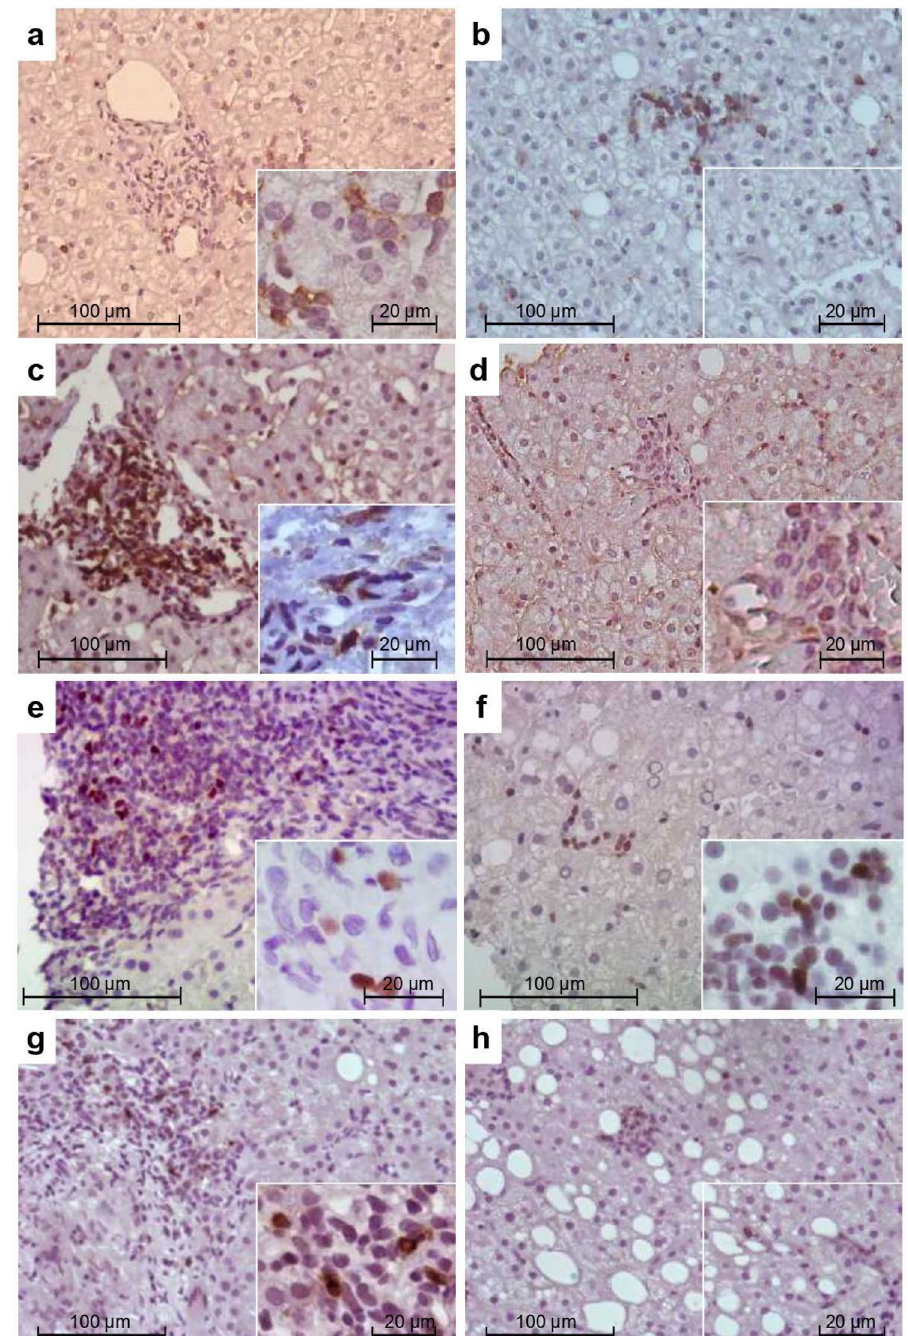
Figure 1. Immunostaining of liver infiltrating lymphocyte populations on formalin-fixed liver biopsies. CD8+ ( a , b ), CD4+ ( c , d ), Foxp3+ ( e , f ) and IL-17A+ ( g , h ) cells. Representative images of portal-periportal ( a , c , e , g ) and intralobular ( b , d , f , h )